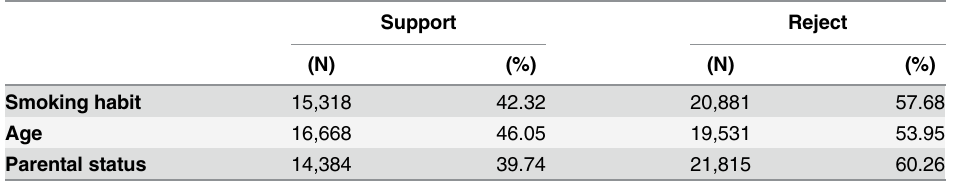
Table 2. Overall proportion of support.